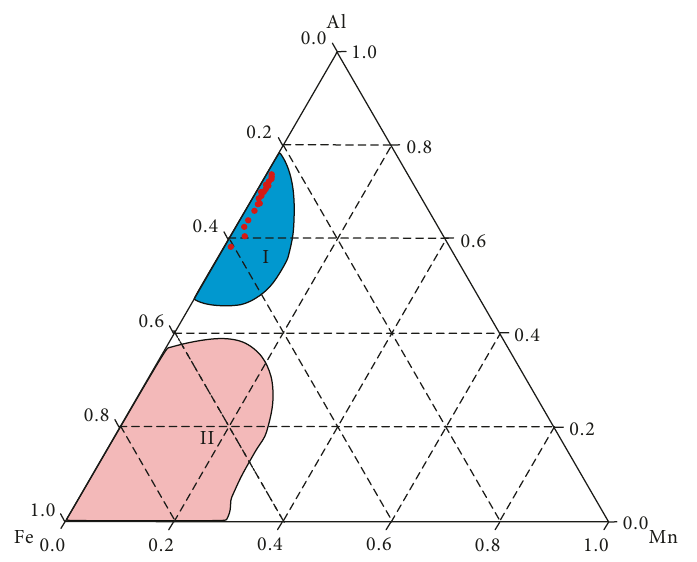
Figure 5: Al-Mn-Fe content and origin analysis diagram for the siliceous minerals from the upper Ordovician Wufeng Formation-lower Silurian no. 1 member of the Longmaxi Formation in the X-1 well. The values of excess silicon are nearly all in the biogenic zone, indicating that the excess silicon is derived from biogenesis. The base map is from Wedepohl [20], Adachi et al. [21], and Yamamoto [22]. See Figure 1 for the well location. I: bio-origin; II: hydrothermal